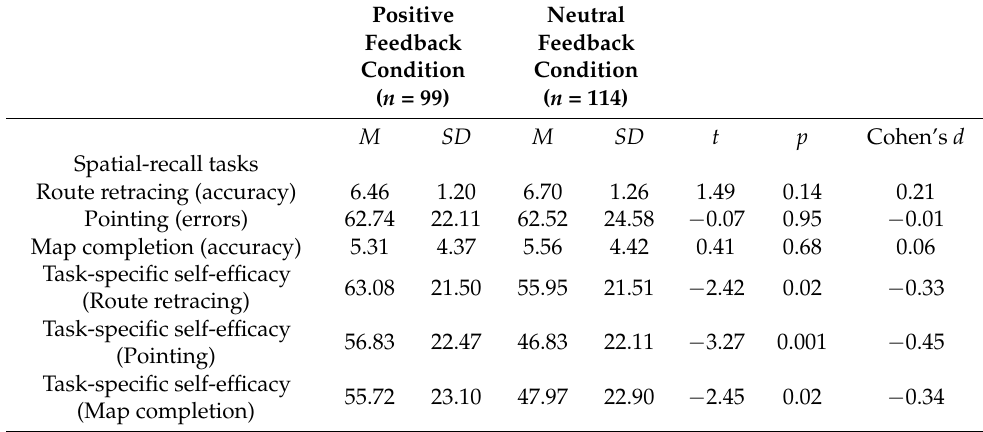
Table 1. Independent sample t -test.